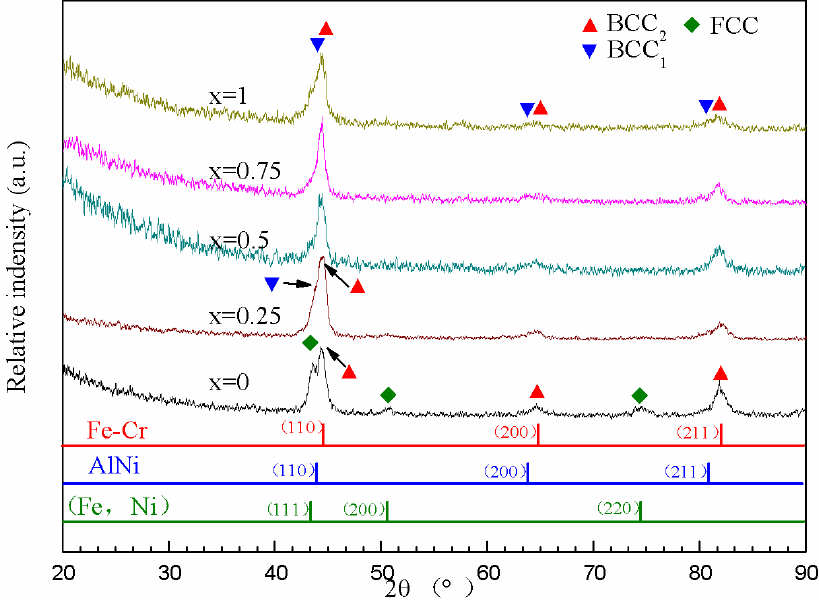
Figure 1. XRD results of FeCoCrNiAlTi x high ‐ entropy alloy (HEA) coatings.